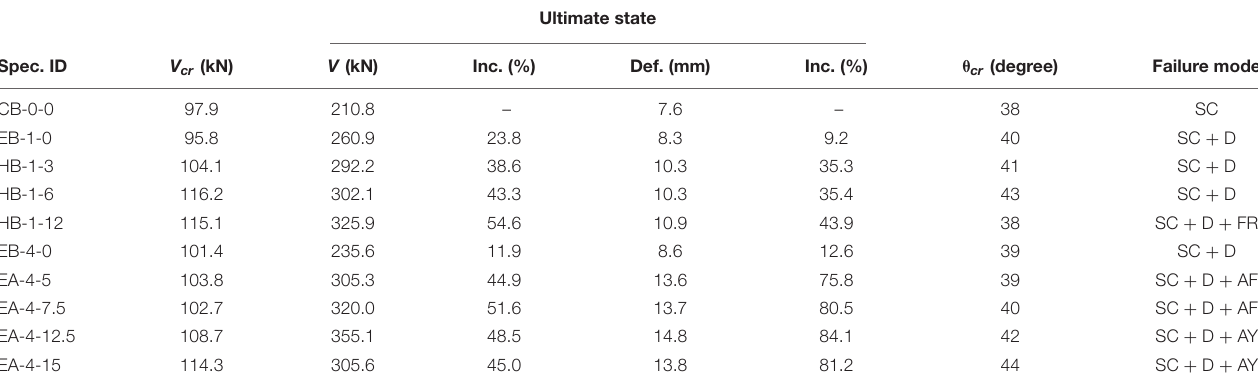
TABLE 3 | Characteristic points of tested